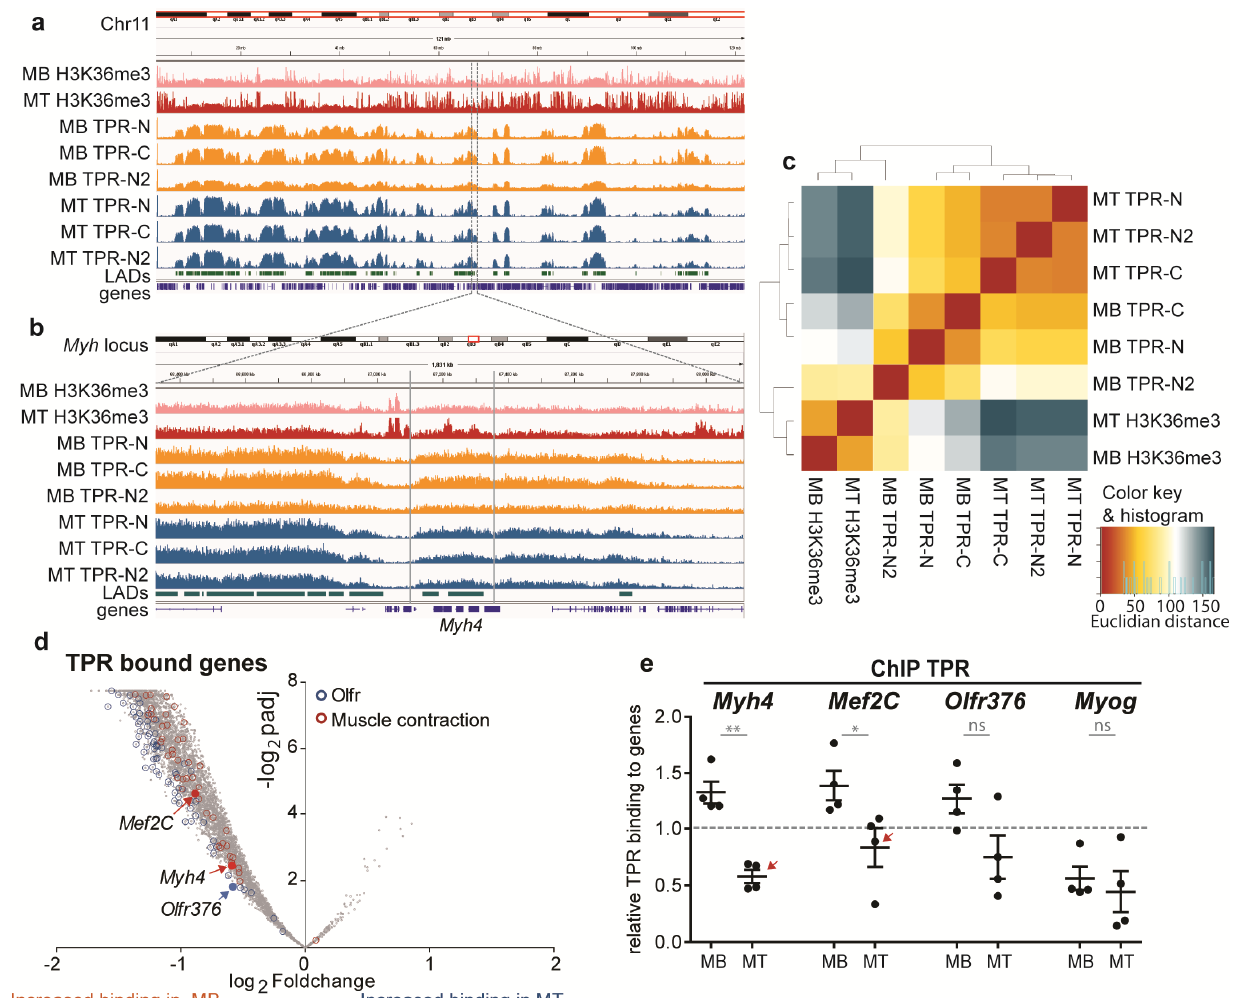
Figure 3. ChIP-sequencing reveals TPR binding in C2C12 MBs and MTs (differentiated for 4 days). ( a ) A comparison of binding patterns of H3K36me3 (top), TPR (middle) and Lamin B1-associated domains (LADs; bottom, [46]) within chromosome 11 in MBs and MTs. ( b ) Zoom-in to the TPR bound domain shows differential binding at Myh4 between MBs and MTs (region of differential binding highlighted by gray lines). ( c ) Hierarchical clustering analysis of TPR binding in genes. Hits gained by TPR-N and TPR-C clustered together in MBs and MTs. ( d ) Volcano plot reveals the distribution of genes depending on p -value, adjusted for multiple correction (Benjamini–Hochberg adjustment, padj), and fold change of TPR binding between C2C12 MBs and MTs. Olfactory receptor genes are marked in blue and genes related to muscle contraction in red. Highlighted Mef2C , Myh4 and Olfr376 are representative genes for further experiments. ( e ) ChIP–qPCR confirms the ChIP-Seq data (n = 5): TPR binds Mef2C , Myh4 and with decreased values also Olfr376 in MBs; the binding is reduced in MTs. TPR binding to Myog was below the threshold. Data normalized to H3 binding in respective samples: H3 binding is equal to 1 = threshold. qPCR and WB data were square root transformed prior to statistical evaluation: Welch’s t -test. Each dot represents one biological replicate; error bars represent s.e.m. *, p < 0.05; **, p < 0.01; ns, non-significant.